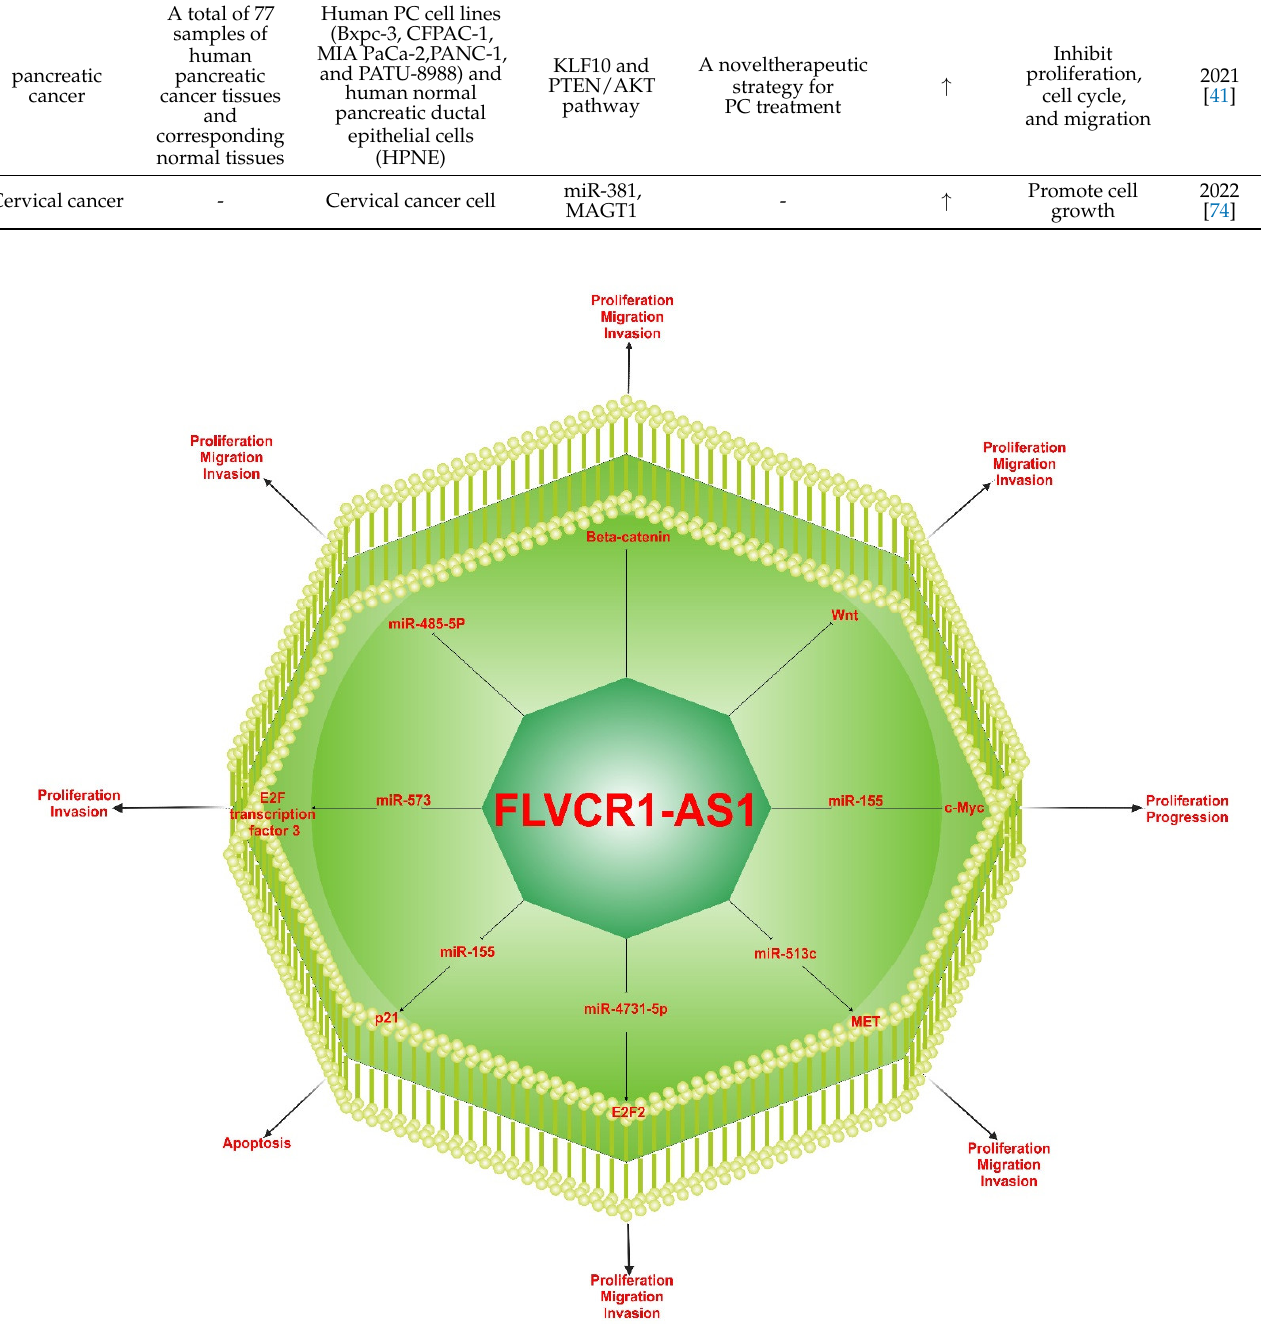
Table 3. Functional characterizations of FLVCR1-AS1 in multiple human cancers. ↑ in the table indicates upregulation. Cancer Type